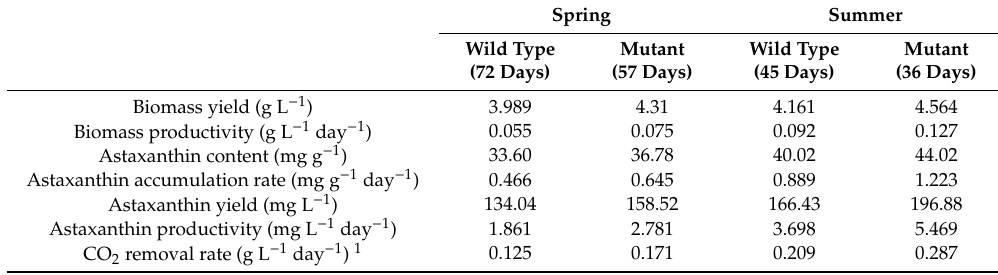
Table 1. Comparison of biomass production, astaxanthin production, and CO 2 removal rate between H. pluvialis cells of wild type and mutant under outdoor spring and summer conditions.